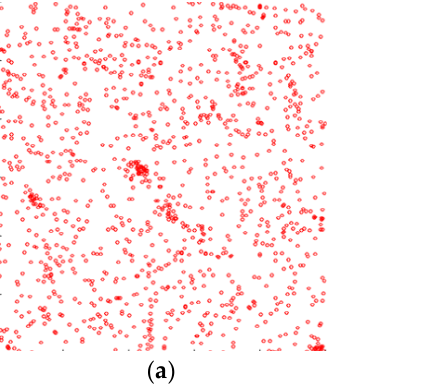
(cid:26) (cid:95) (cid:27) L ( d )